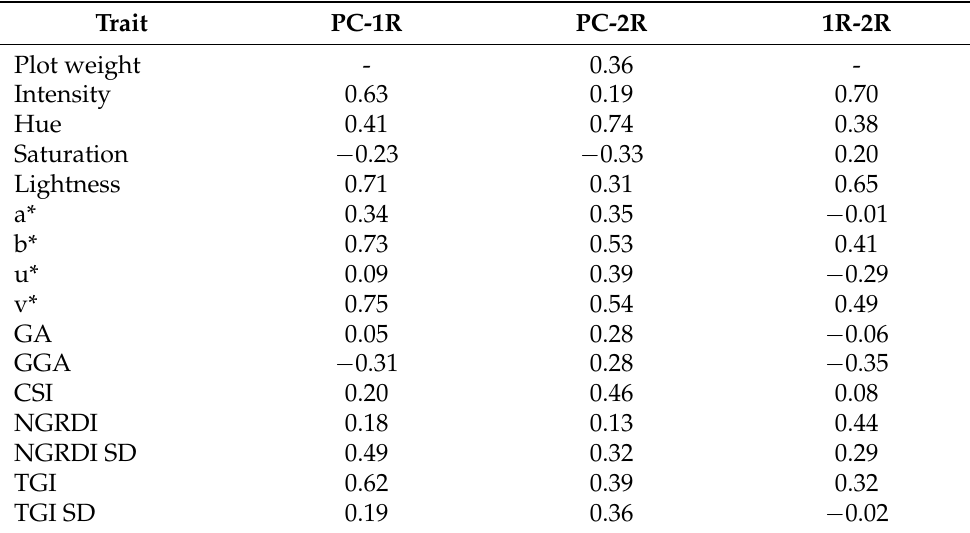
Table 3. Phenotypic correlations of spectra traits and plot weight between years. Trait